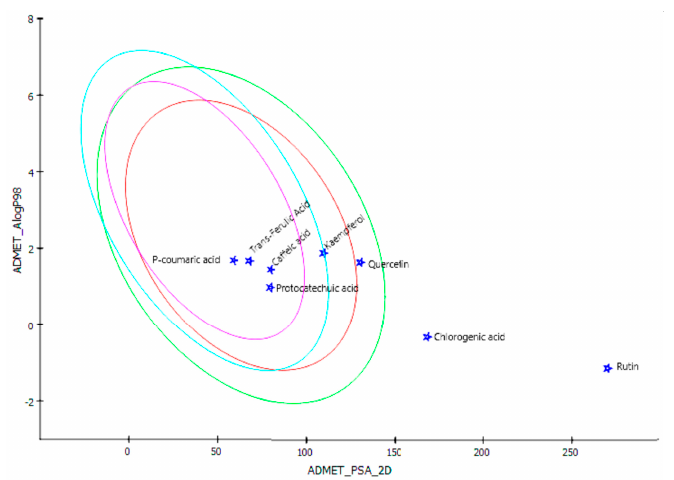
Figure 10. ADME analysis. Blue stars represent the proposed compounds of C. papaya